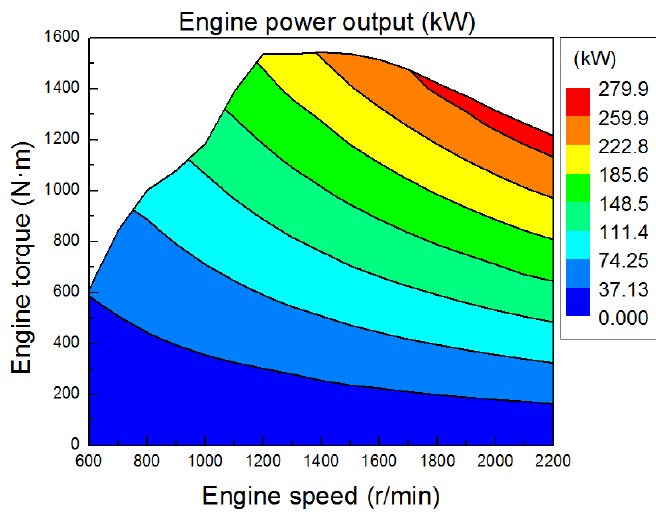
Figure 5. Heat transfer temperature difference between T